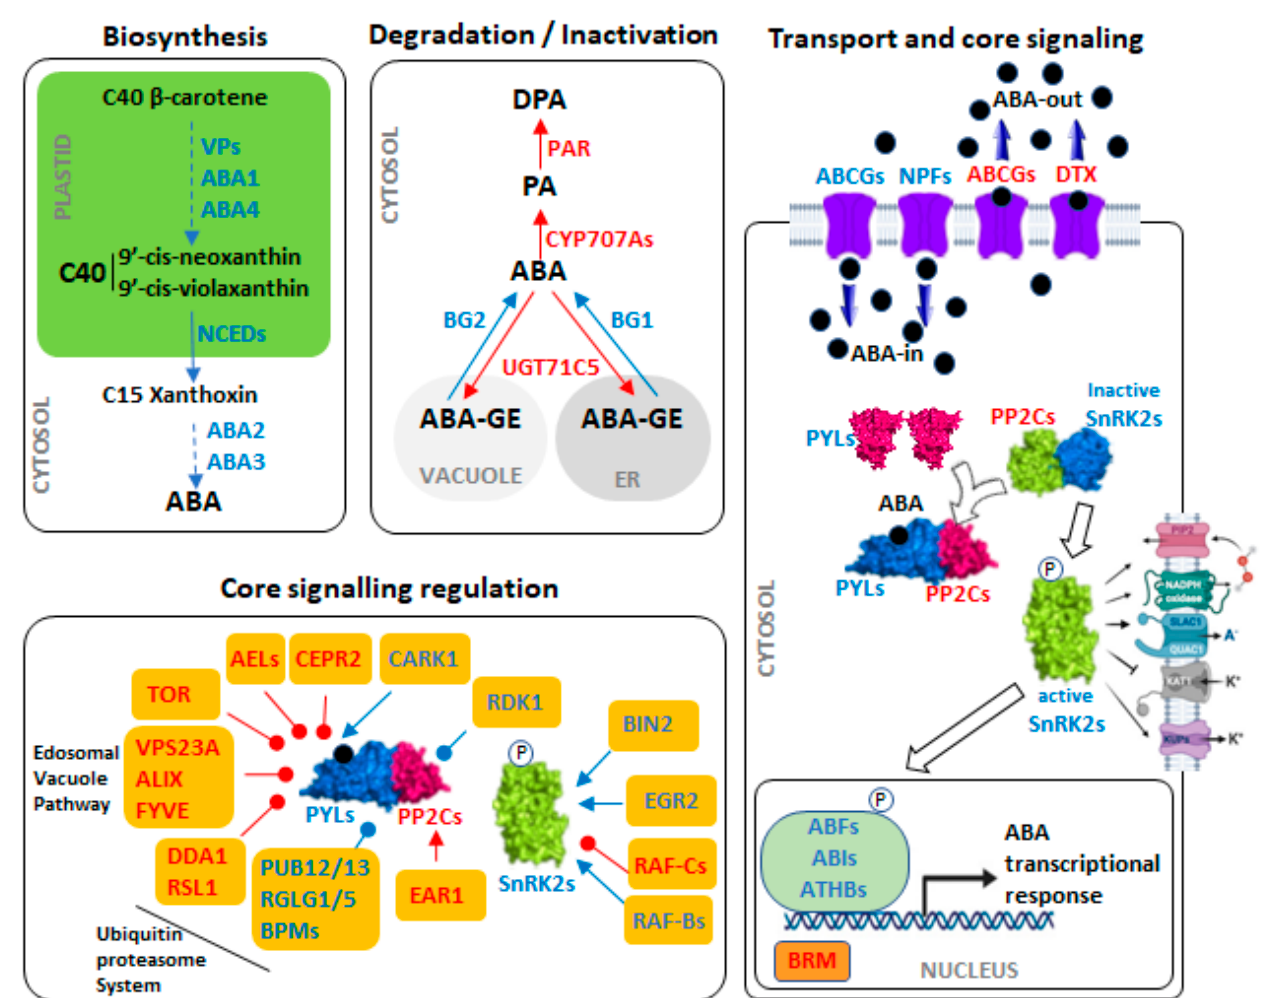
Figure 2. Abscisic acid (ABA) machinery. Biosynthesis: ABA is synthesized from β -carotene (C40) through the carotenoid pathway. Steps from β -carotene (C40) to xanthoxin (C15) take place in plastids. In the cytoplasm, ABA2 and ABA3 convert xanthoxin into active ABA. Conversion of 9 ′ -cis-neoxanthin and 9 ′ -cis-violaxanthin to xanthoxin by NCEDs is a rate-limiting step in ABA biosynthesis. Degradation/Inactivation: active ABA level is regulated by catabolism through both ABA conjugation and catalytic hydroxylation. ABA can be glycosylated into inactive ABA-GE by UGT71C5. On the other hand, AtBG1 and AtBG2 can modify ABA-GE to produce active ABA. Further, ABA can be catalyzed to phaseic acid (PA) by CYP707As, which in turn is catalyzed to dihydrophaseic acid (DPA) by PA reductase (PAR). Transport and Core Signaling: ABA transport is carried out by ABCGs, NPFs and DTX transporters. Inside the cell, ABA is perceived by PYR/PYL/RCAR receptors, either at cytosol or nucleus, forming a stable ternary complex with clade A PP2Cs. The formation of this complex allows the activation of SnRK2s that leads to ABA-induced regulation of plasma membrane and nuclear targets (i.e., NADPH oxidase, KAT1, SLAC1, and ABFs/AREBs). Core Signaling Regulation: PYLs receptors, PP2Cs and SnRK2s are regulated by several protein kinases. The degradation of ABA signaling core components is regulated both by the ubiquitin-proteasome system, and through the endosomal-vacuole pathways. Components and arrows in blue mean positive function on the final ABA response, while red components and red arrows mean a negative effect. Pointed arrow: activation; rounded arrow: inactivation. (For more information about these components see Table S1).